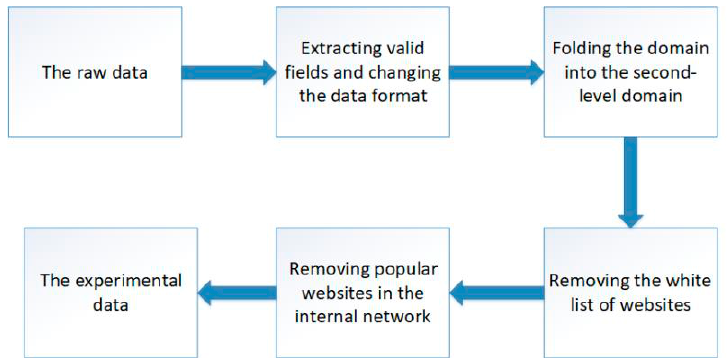
Figure 2. The process of data preprocessing